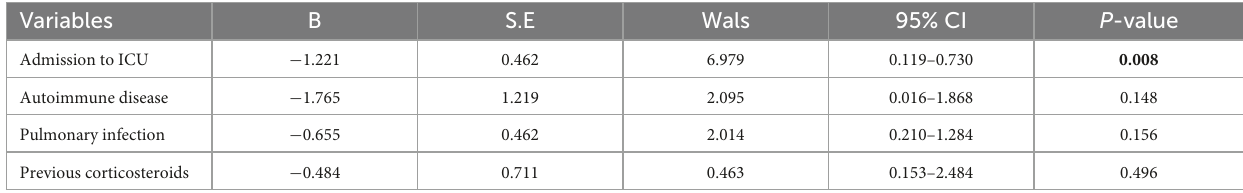
TABLE 3 Multivariate analysis of risk factors for carbapenem-susceptible Enterobacter cloacae complex (CSEC) and carbapenem-resistant Enterobacter cloacae complex (CREC). Variables B